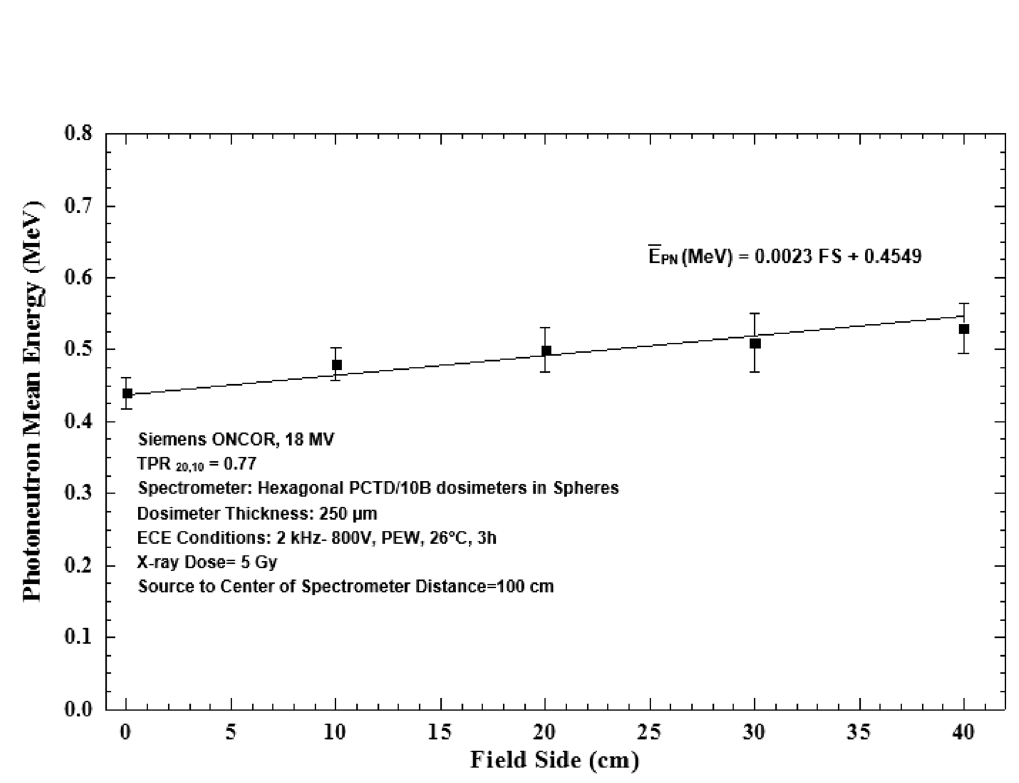
Figure 8. Photoneutron mean energy versus field side for field sizes 0 × 0, 10 × 10, 20 × 20, 30 × 30 and 40 × 40 cm 2 at the isocenter of 18 MV X-ray beams of the medical